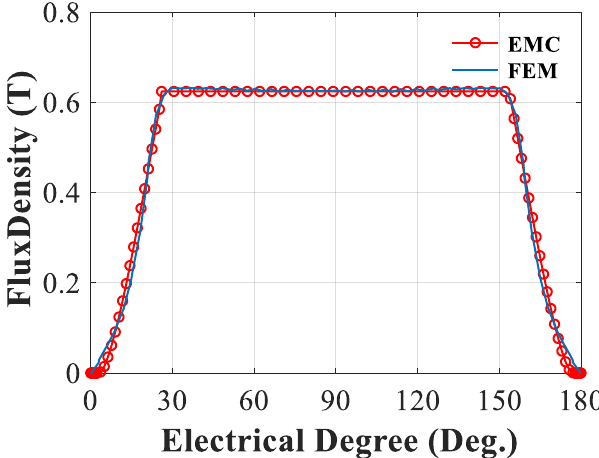
Figure 7. The magnetic flux density distribution of the equivalent magnetic circuit method consid- ering the magnetic saturation of the bridge region.